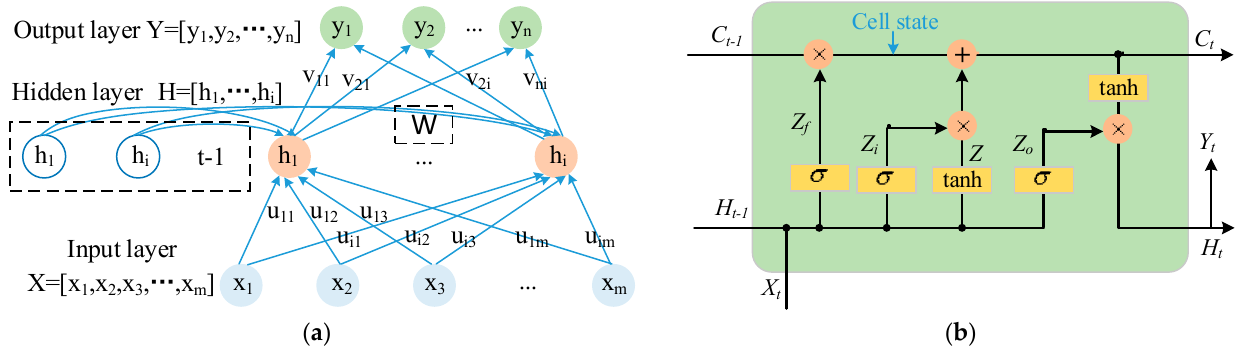
Figure 15. Schematic diagram of weld-quality prediction model: ( a ) recurrent neural network; ( b ) LSTM.